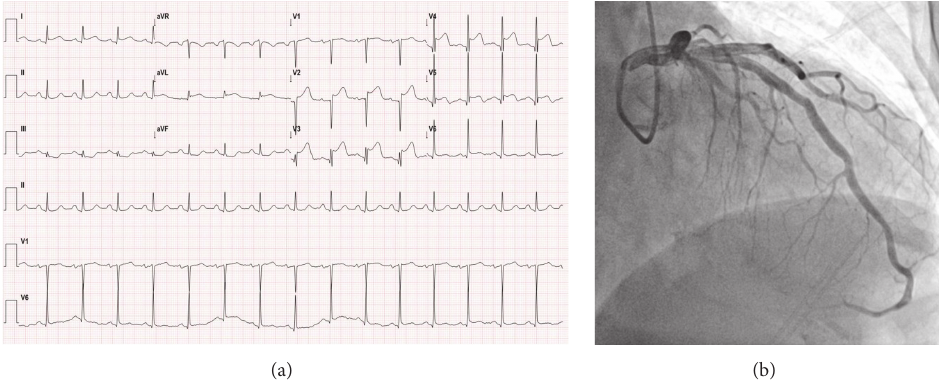
Figure 2: (a) Electrocardiography showed ST segment elevation in precordial leads (V2 ∼ V6). (b) Coronary angiography revealed neither spastic occlusion nor significant narrowing of coronary